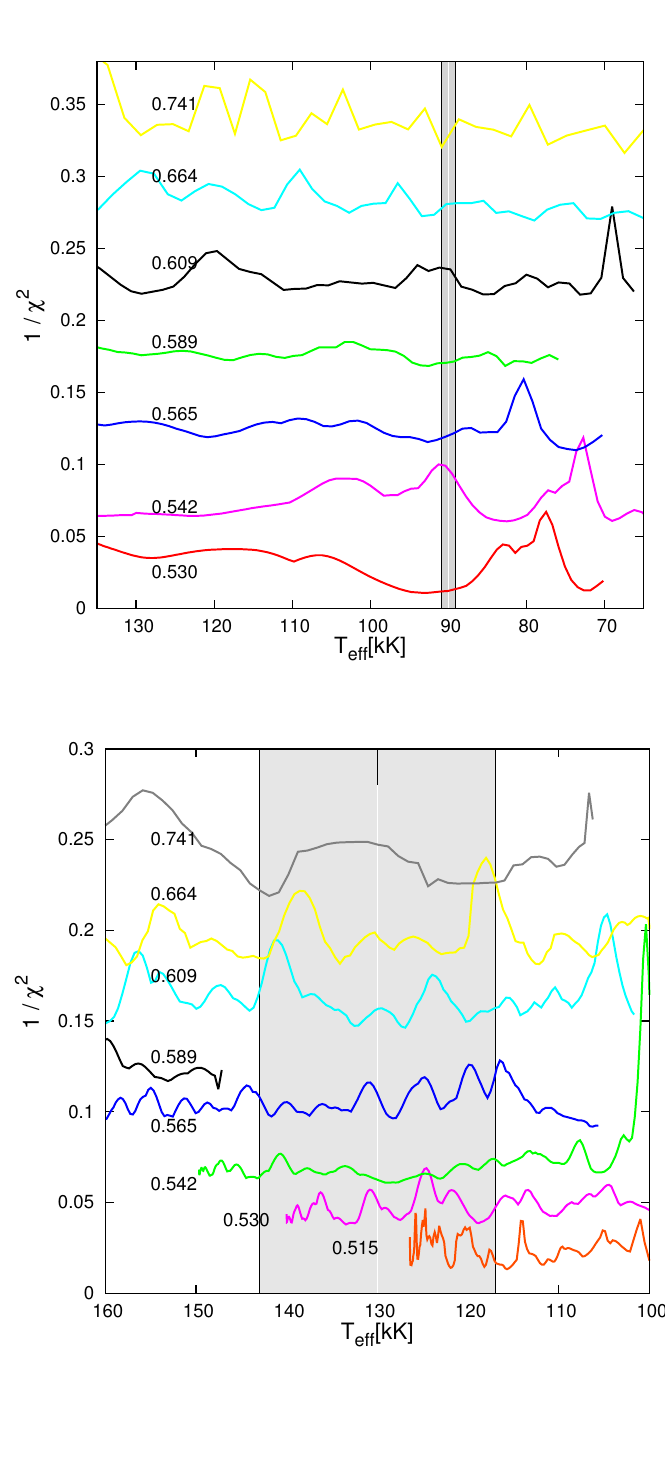
Figure 2. Inverse of the quality function of the period fit considering (cid:3) = 1 g modes vs T e ff for J0349. The curves have been arbitrarily shifted upward for clarity (with a step of 0.05).